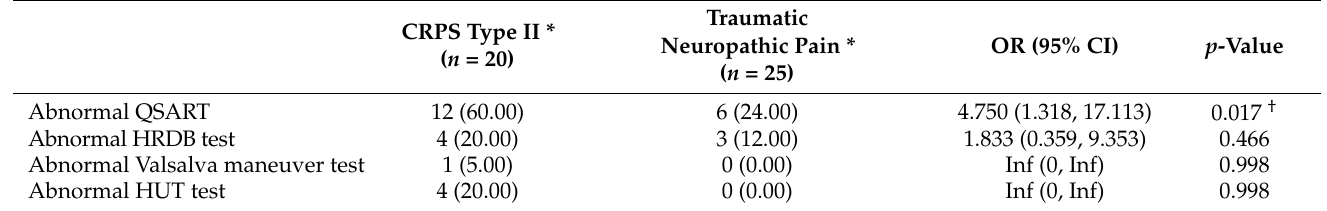
Table 2. Comparison of autonomic function screening test between the CRPS type II group and the traumatic neuropathic pain group.